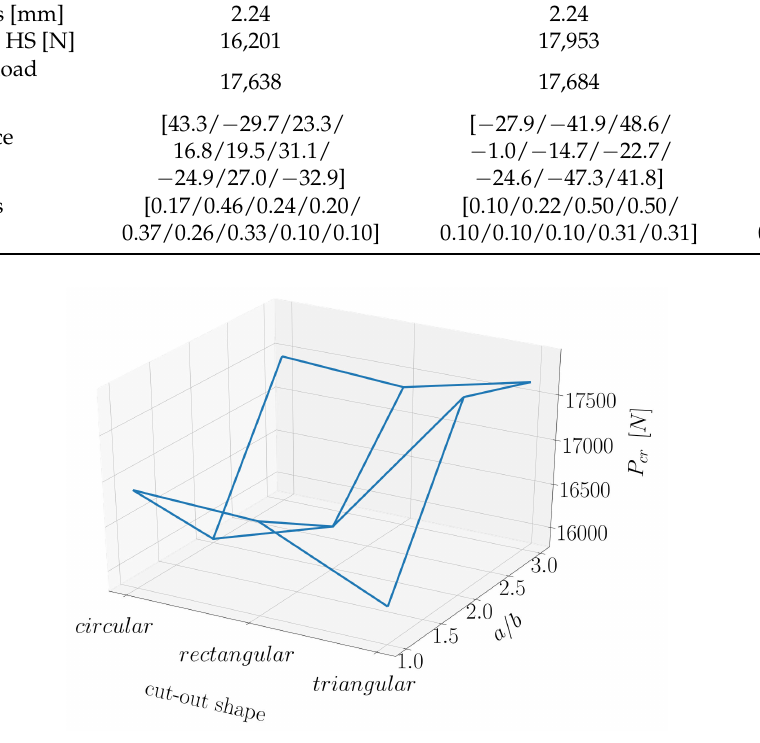
Figure 13. Variation of the buckling load with respect to cut-out shape and aspect